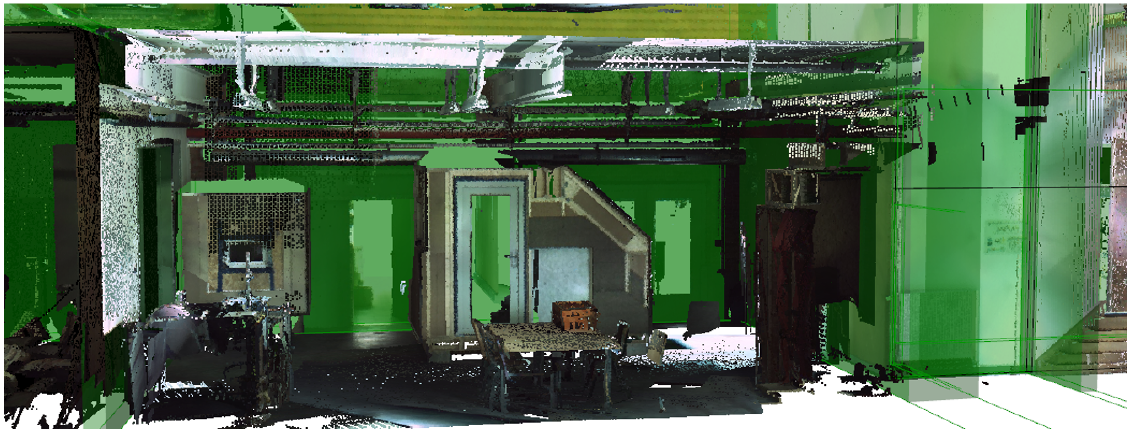
Figure 4: Overview clutter and occlusions wall